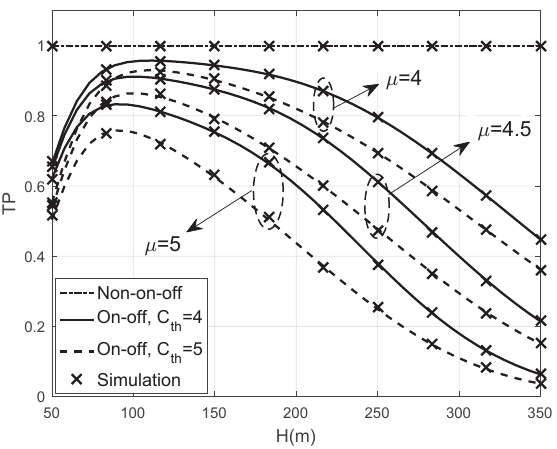
= 9, and λ = 5 × 10 − 4 . U x